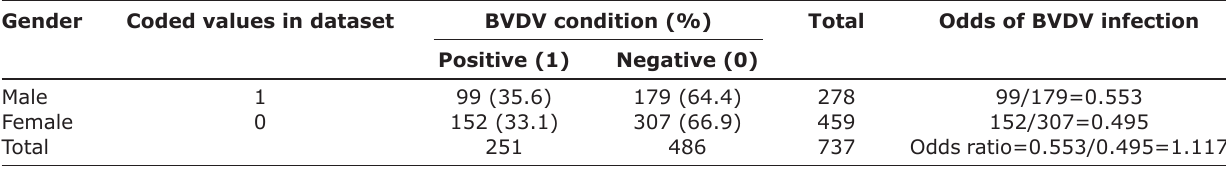
Table-1: Chi-square test for the association between BVD prevalence and gender. Gender Coded values in